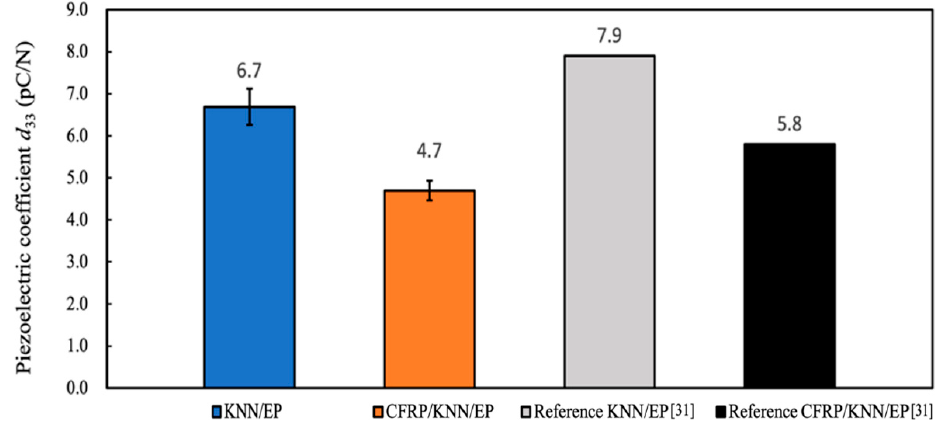
Figure 7. Comparison of the piezoelectric coefficients, d 33 .